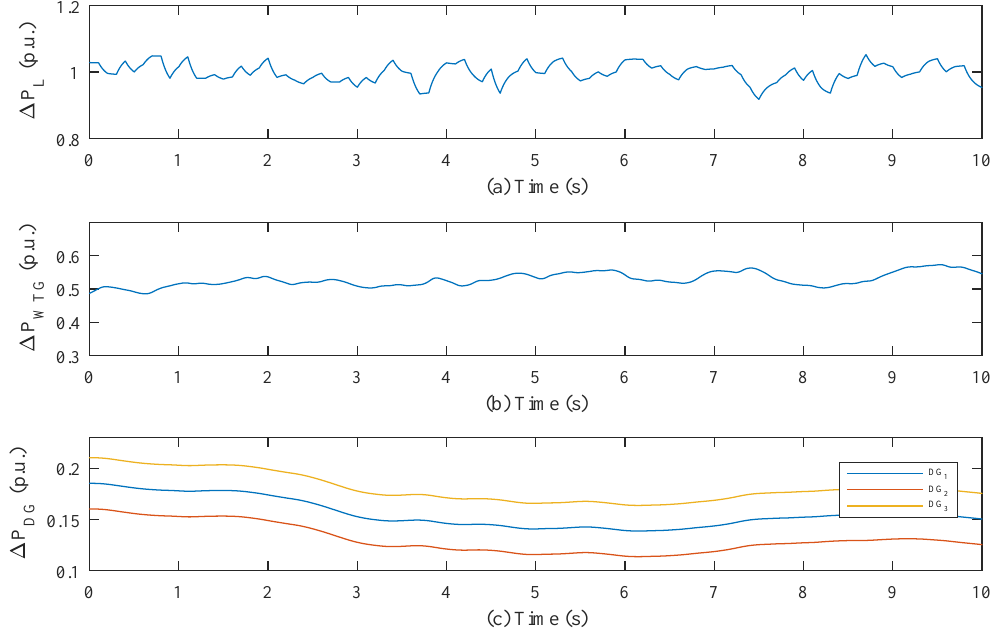
Figure 16. Transient power output of each source with stochastic disturbance. ( a ) Load demand output; ( b ) dynamic response of WTG; ( c ) dynamic response of